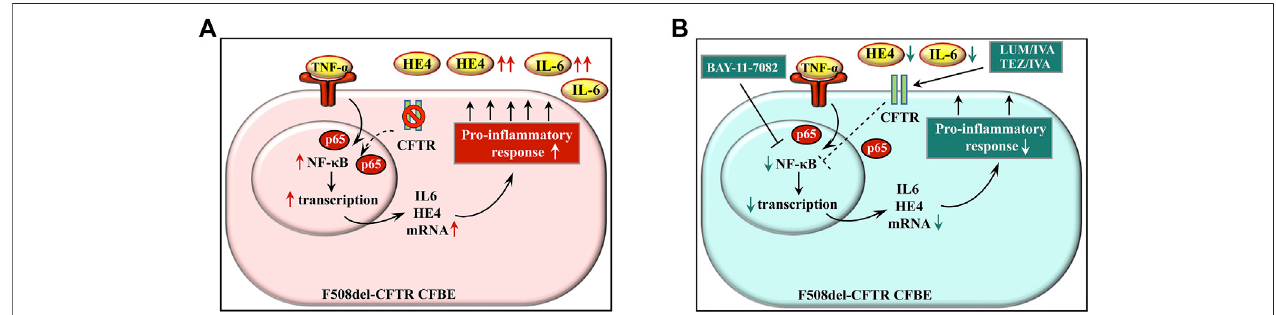
FIGURE 8 | Schematic fi gure about the model on the regulation of HE4 expression in CF via CFTR and pro-in fl ammatory signaling. There is an increased basal expressionofHE4withcytokines(e.g.,IL-6)inlungepithelialcellsofCFthatiscausedbyCFTRdysfunctionandexternalpro-in fl ammatorystimuli,e.g.,TNF- α viatheNF- κ B pathway (A) Blocking the effect of TNF- α by BAY 11-7082 or using CFTR modulators (LUM/IVA or TEZ/IVA) can effectively reduce pro-in fl ammatory response in CFBE cells by suppressing the NF- κ B pathway with a still unknown mechanism (dotted line) that prevents IL-6 and HE4 overexpression (B) Abbreviations: CFBE cell: cystic fi brosis bronchial epithelial cell, CFTR: cystic fi brosis transmembrane conductance regulator, TNF- α : tumor necrosis factor alpha, HE4: human epididymis protein 4, IL-6: interleukin-6, NF- κ B: nuclear factor-kappa